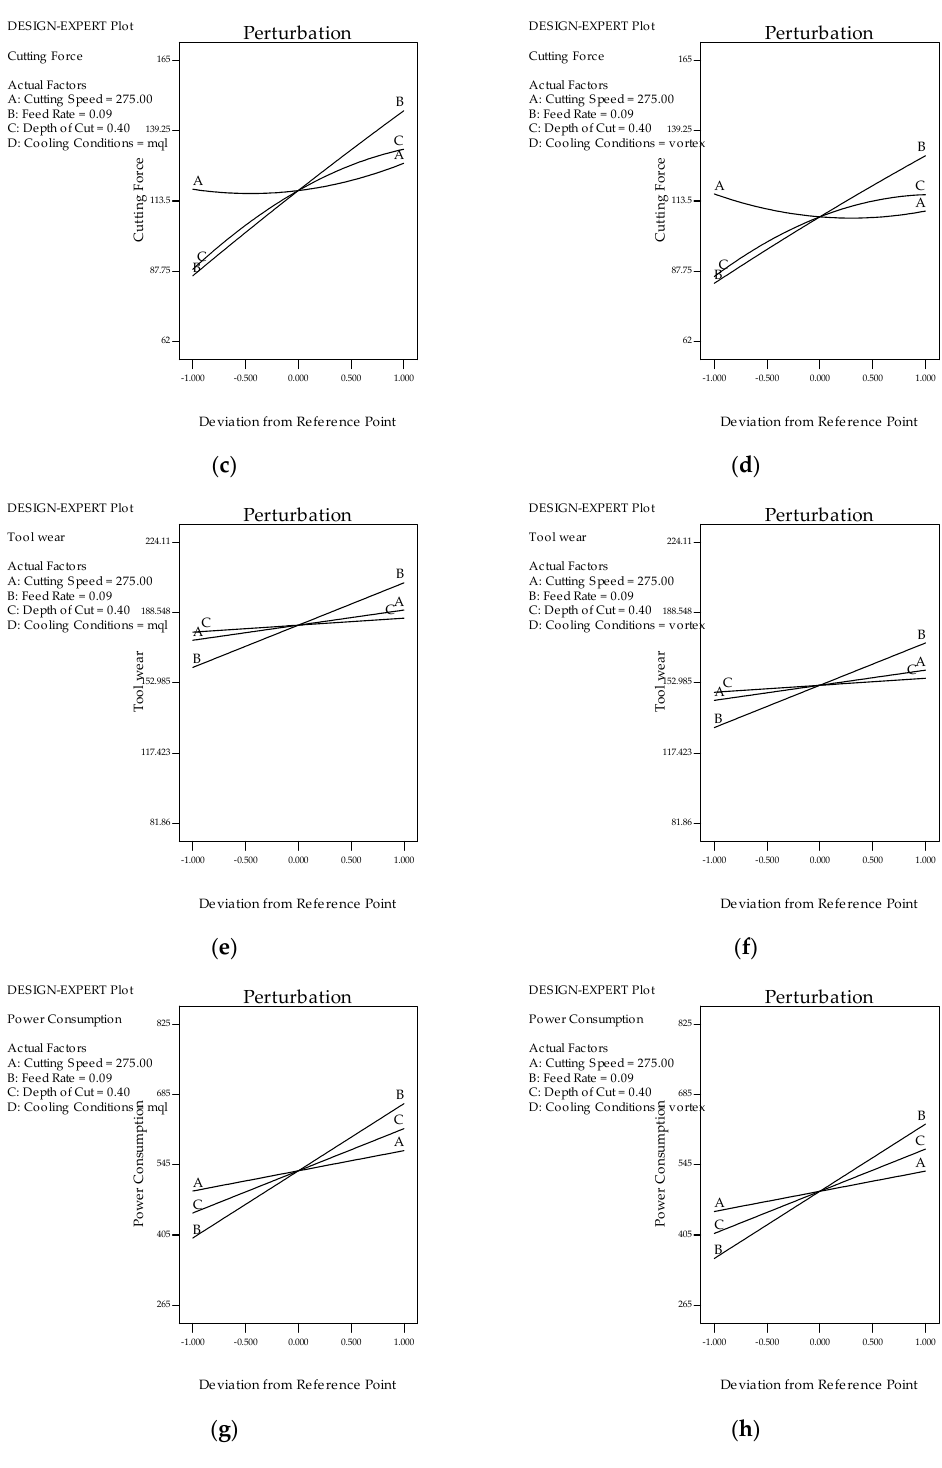
Figure 3. ( a ) Perturbation analysis for R a under the MQL technique; ( b ) perturbation analysis for R a under the VMQL technique; ( c ) perturbation analysis for F c under the MQL technique; ( d ) perturbation analysis for F c under the VMQL technique; ( e ) perturbation analysis for VBmax under MQL cooling; ( f ) perturbation analysis for VBmax under the VMQL technique; ( g ) perturbation analysis for P under thermal technique; ( h ) perturbation analysis for P under the VMQL technique at v c = 275 m/min, f = 0.09 mm/rev, and a e = 0.4 mm. (A = cutting speed; B = feed; C = depth of cut, where the X-axis represents the coded values and the Y-axis represents the selected responses)